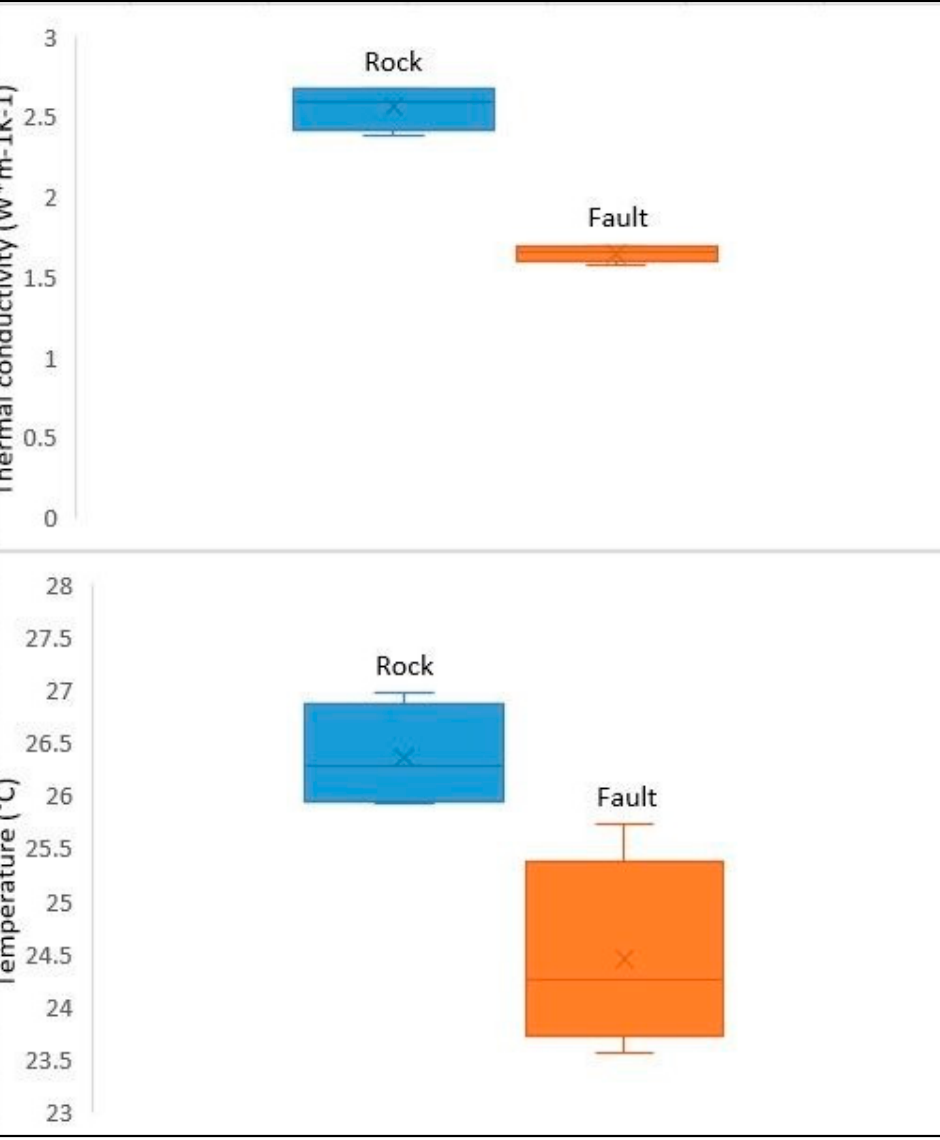
Figure 13. Field data relative to thermal conductivity (above) and temperature (below) both for cataclastic fault zone (Orange) and low fractured rock mass (Blue). Estimated errors in the measurement are represented by vertical error bars.